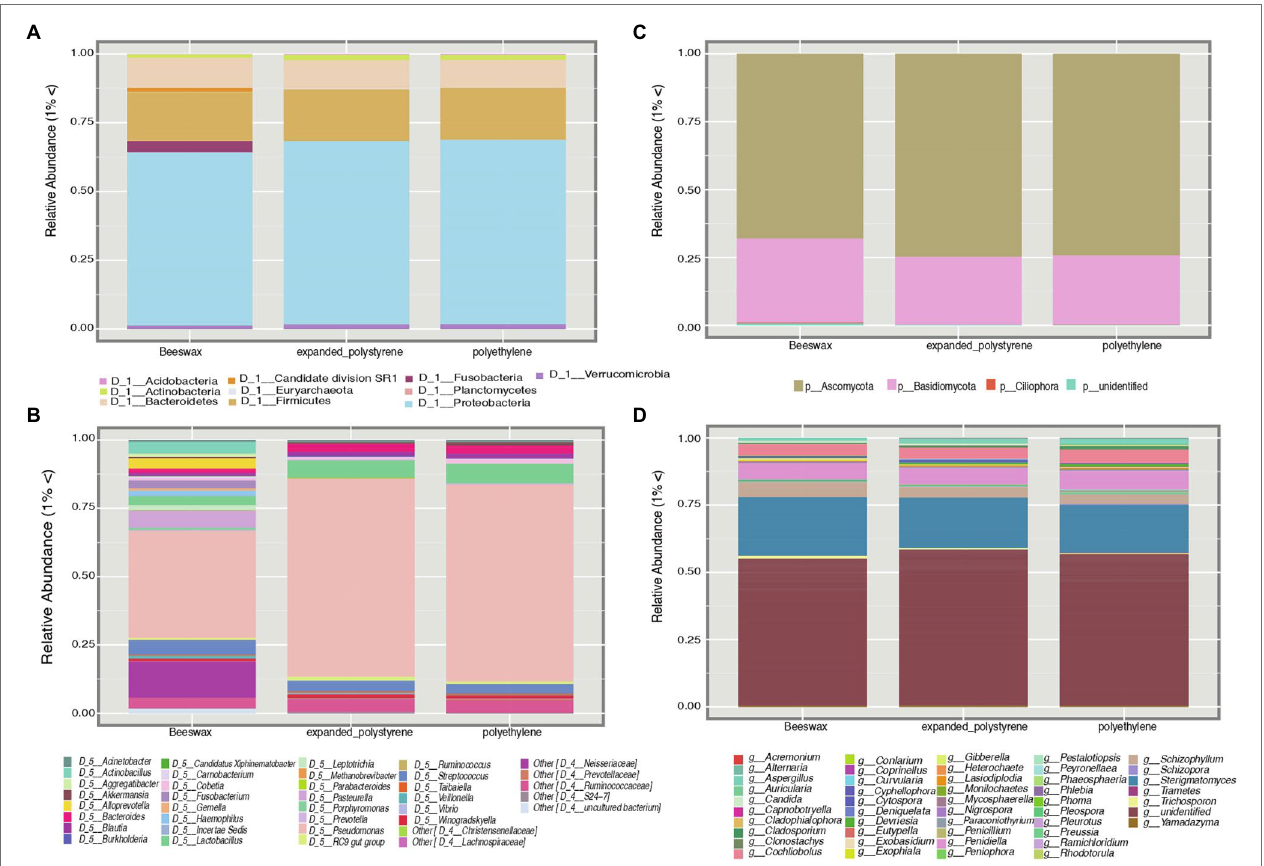
FIGURE 2 | Composed panel depicting taxonomic plots of bacterial diversity at the phyla level (A) and genus level (B) . Plots corresponding to fungal diversity at the phyla (C) and genus level (D) . The legend shows the taxa with more than 1% of